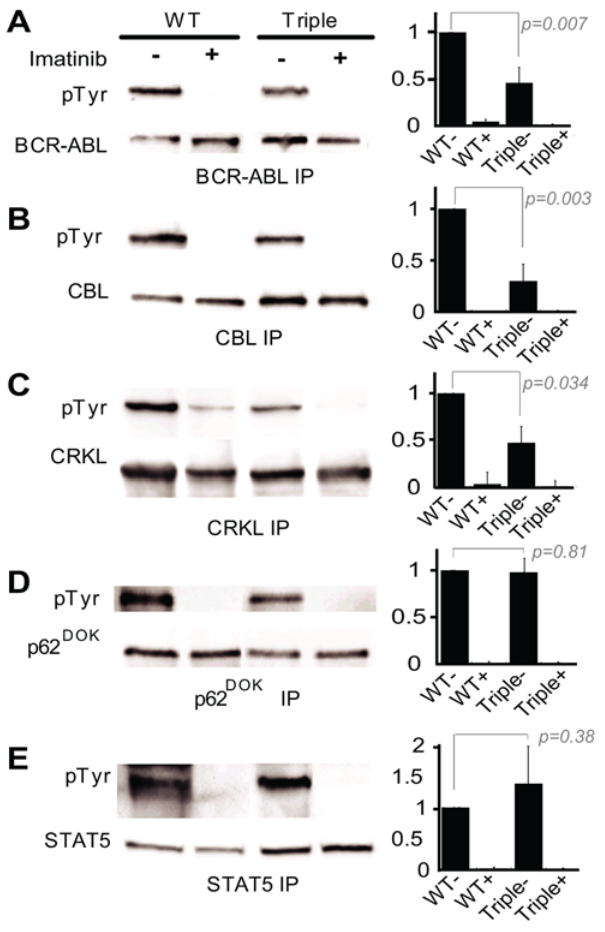
Figure 4. Phosphorylation of various BCR-ABL substrates in wild type and triple mutant BCR-ABL expressing cell lines. Phosphotyrosine levels were determined by immunoprecipitating the indicated proteins from BCR-ABL expressing 32D cell lines and immunoblotting with an anti-phosphotyrosine antibody. The levels of phosphorylation were normalized for the levels of the immunoprecip- itated protein, and phosphorylation is reported relative to wild type (right panel). (A) BCR-ABL; (B) CBL; (C) CRKL; (D) p62 DOK ; (E) STAT5. Treatment with 10uM imatinib inhibited phosphorylation of all substrates examined. Data represents three separate experiments, with a representative blot for each shown in the left panels.